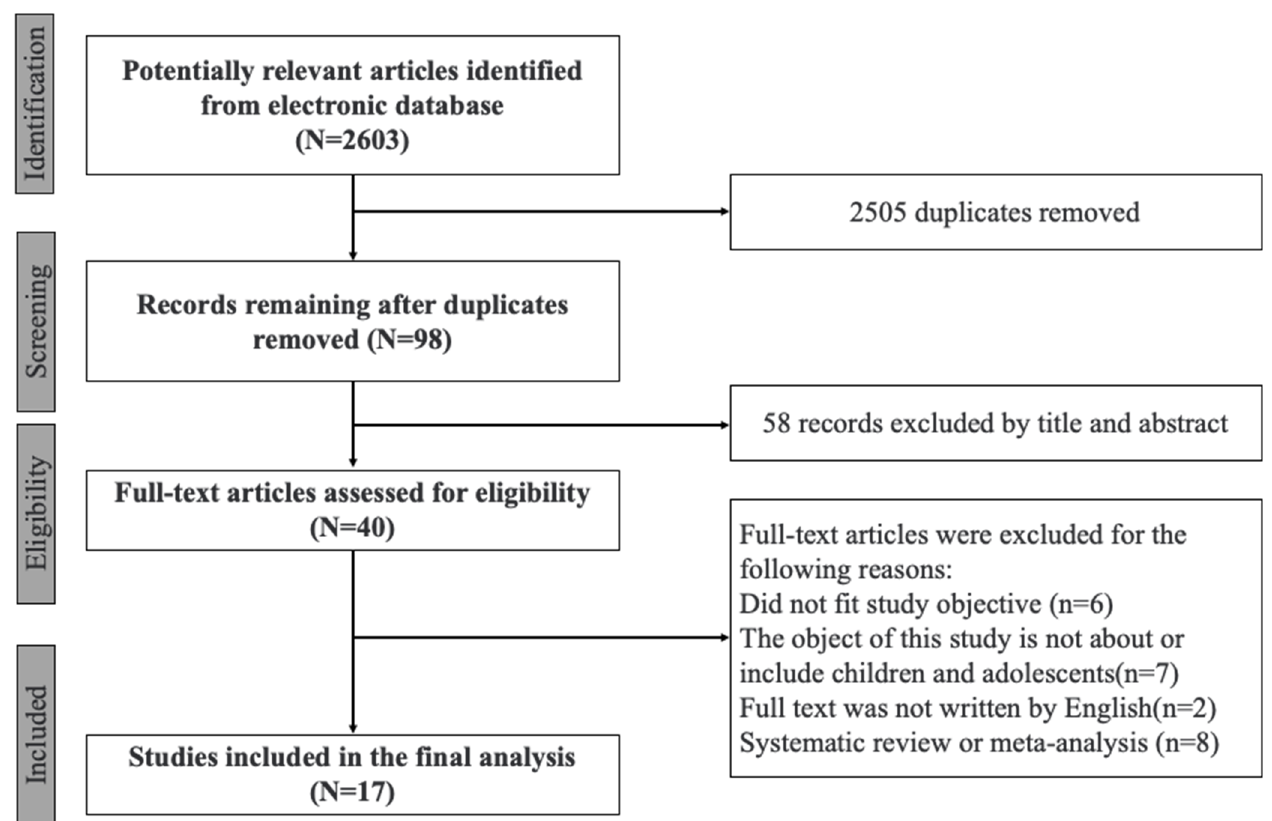
Figure 1. The selection of study included in this scoping review. Step 4: charting the data.